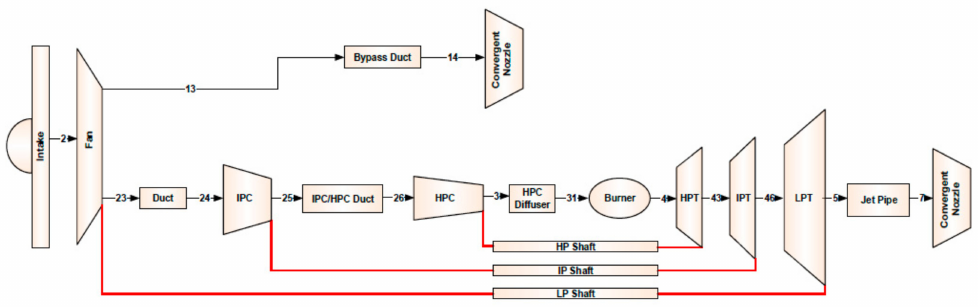
Figure 1. Schematic diagram of the modeled